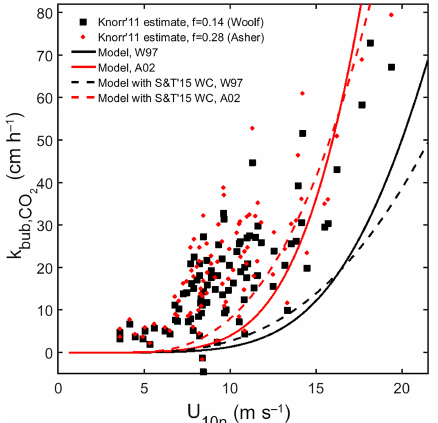
) as Figure 8. Bubble-mediated transfer velocity of CO 2 ( k bub , CO 2 a function of wind speed. Individual points are Knorr_11 obser- vations using solubility and diffusivity scaling from Woolf (1997) (black squares) and Asher et al. (2002) (red circles). Continuous lines are model calculations of k bub , CO using the Knorr_11 wind 2 speed versus whitecap areal fraction relationship (see Fig. 2) and mean SST (Woolf, 1997: black; Asher et al., 2002: red). Model cal- culations were also performed using the Schwendeman and Thom- son (2015) wind speed versus whitecap areal fraction relationship (dashed